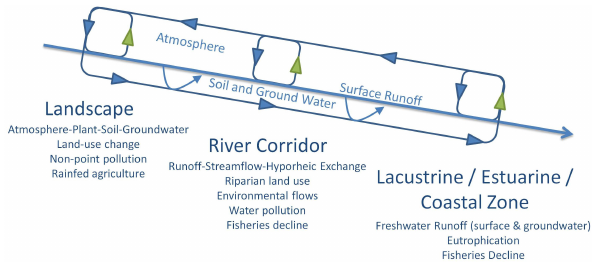
Fig. 1. Schematic representation of spheres of ecohydrology and key processes and issues highlighted in this paper. Spheres are inte- grated in the continuum of the hydrological cycle and considered in the context of hydrographic catchments extending from headwater landscapes to estuaries and coastal